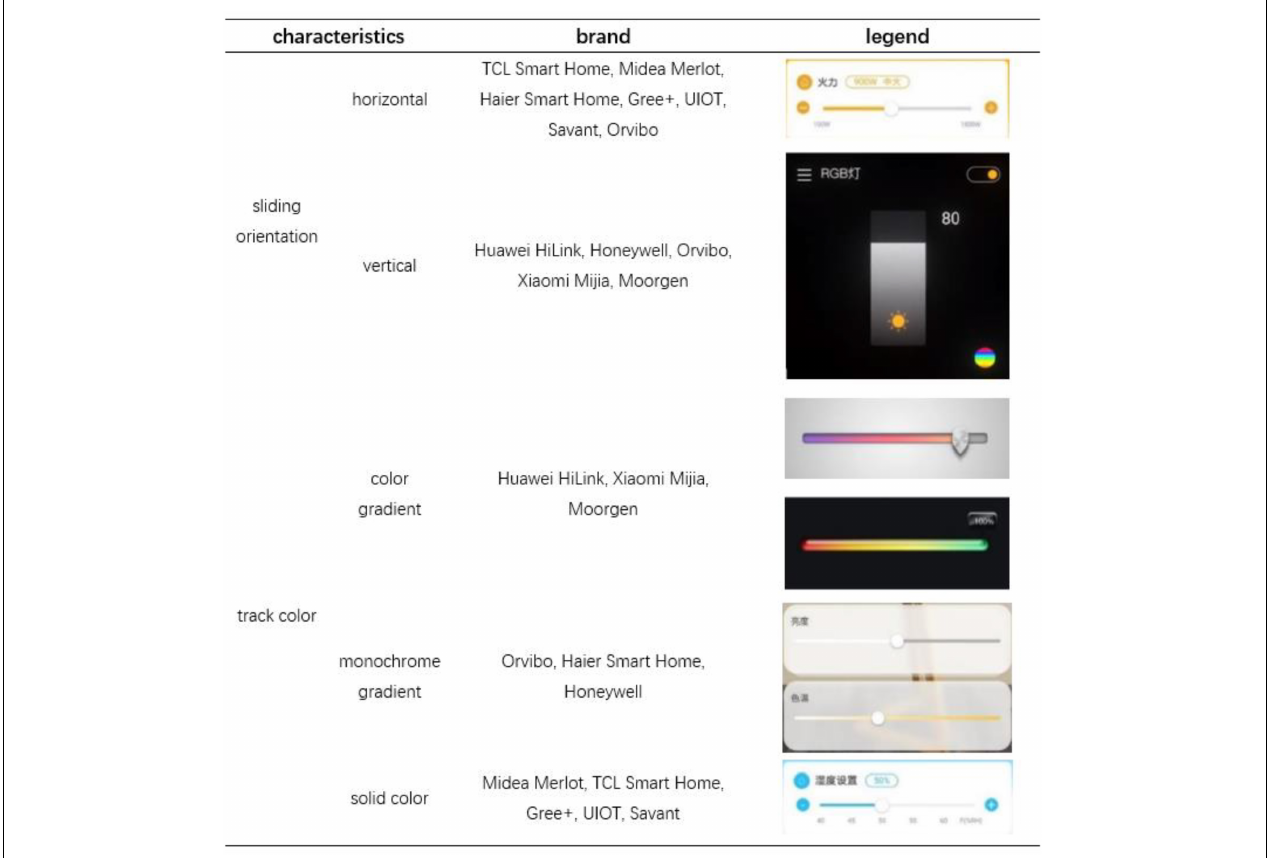
FIGURE 1 | Smart home sliding component survey. The slider orientation in the Chinese smart home market is mainly horizontal and vertical, and the track color can be divided into color gradient, monochrome gradient, and solid color.